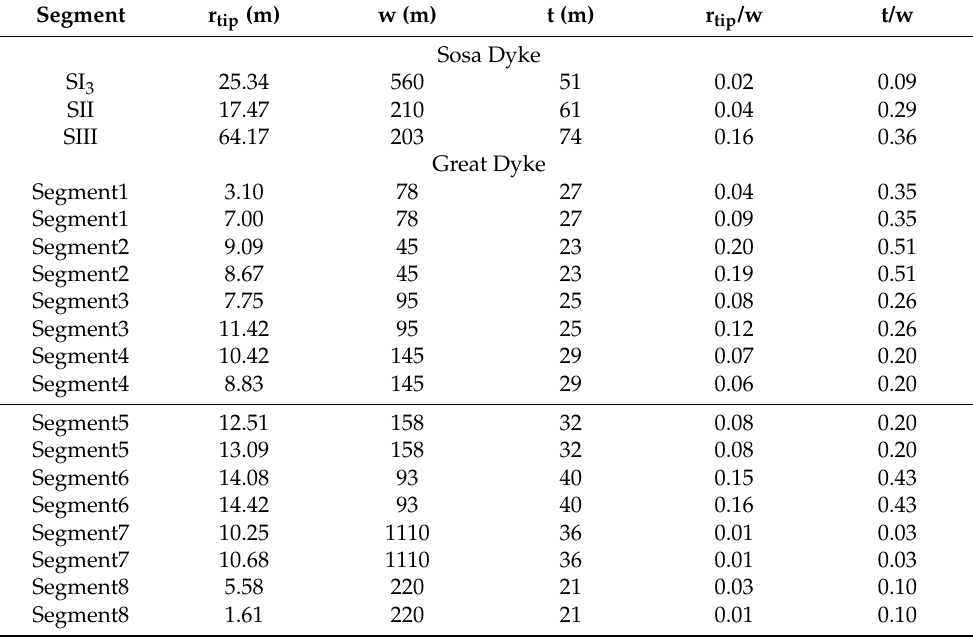
Table A4. Sosa and Great Dyke data for Figure 9.